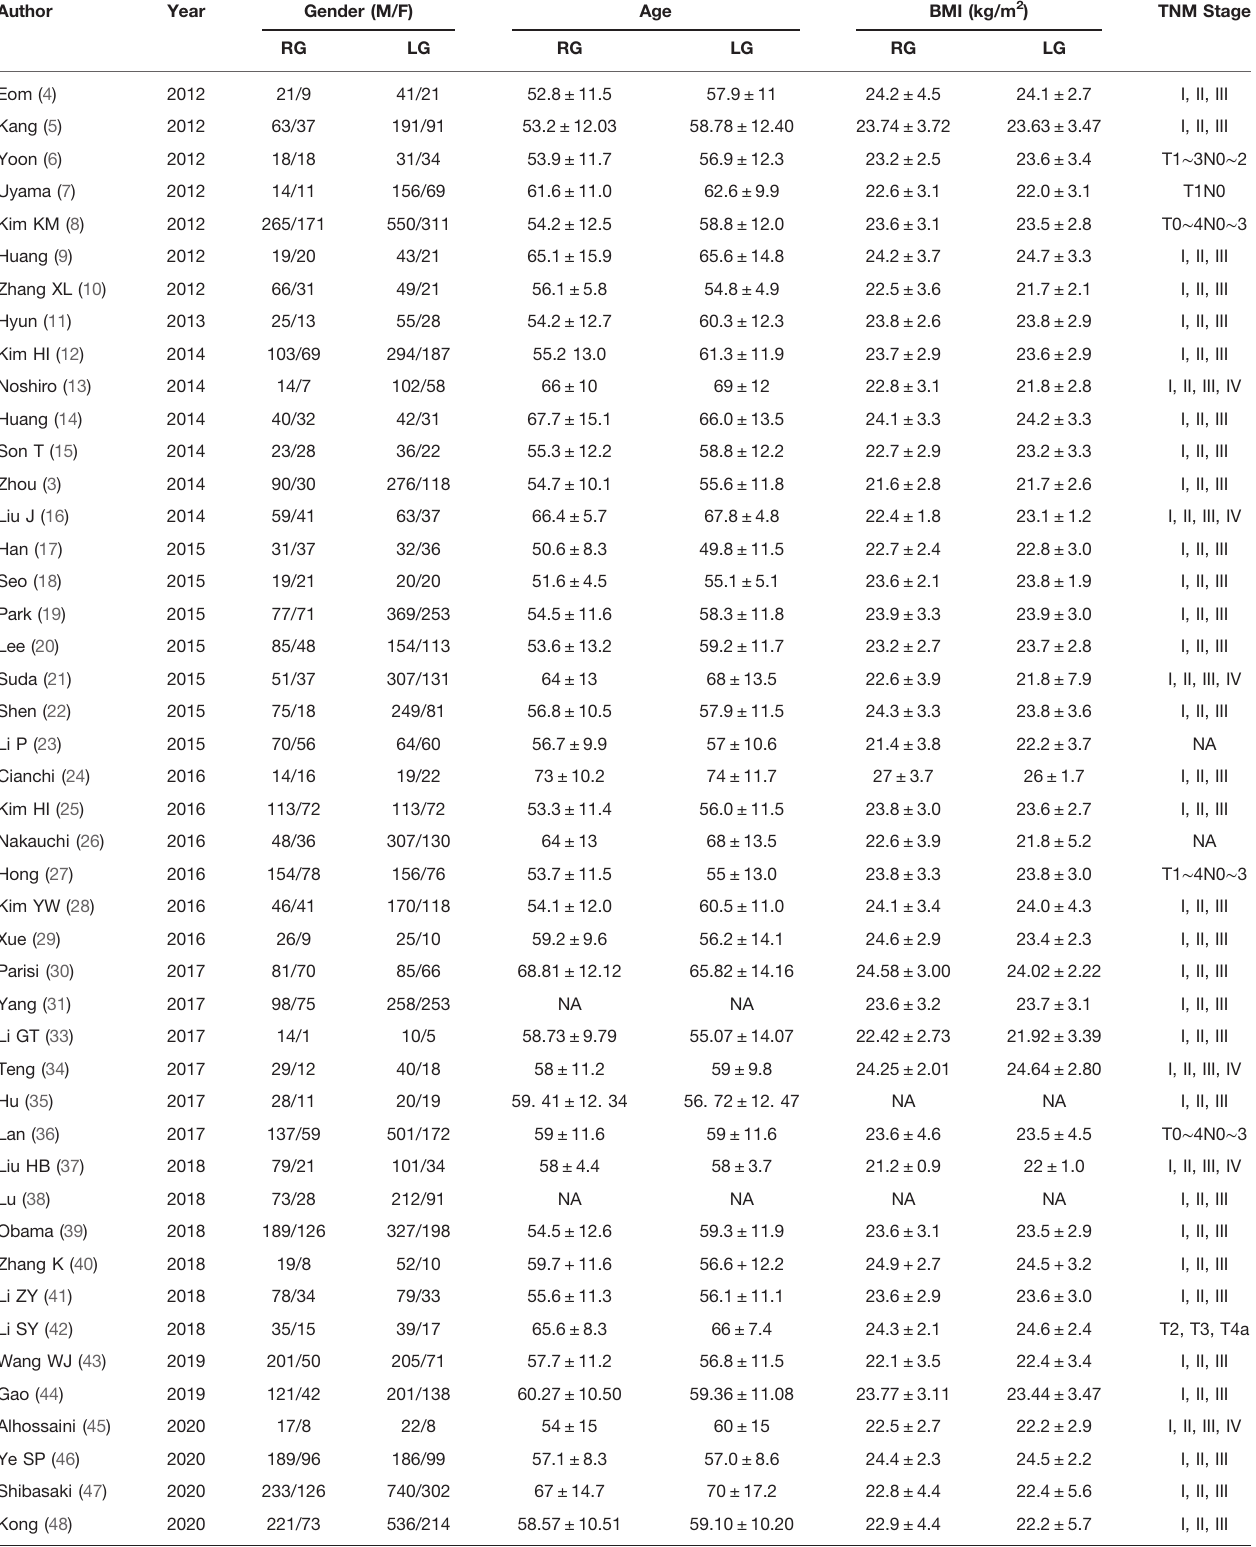
TABLE 2 | Patients ’ characteristics of the included